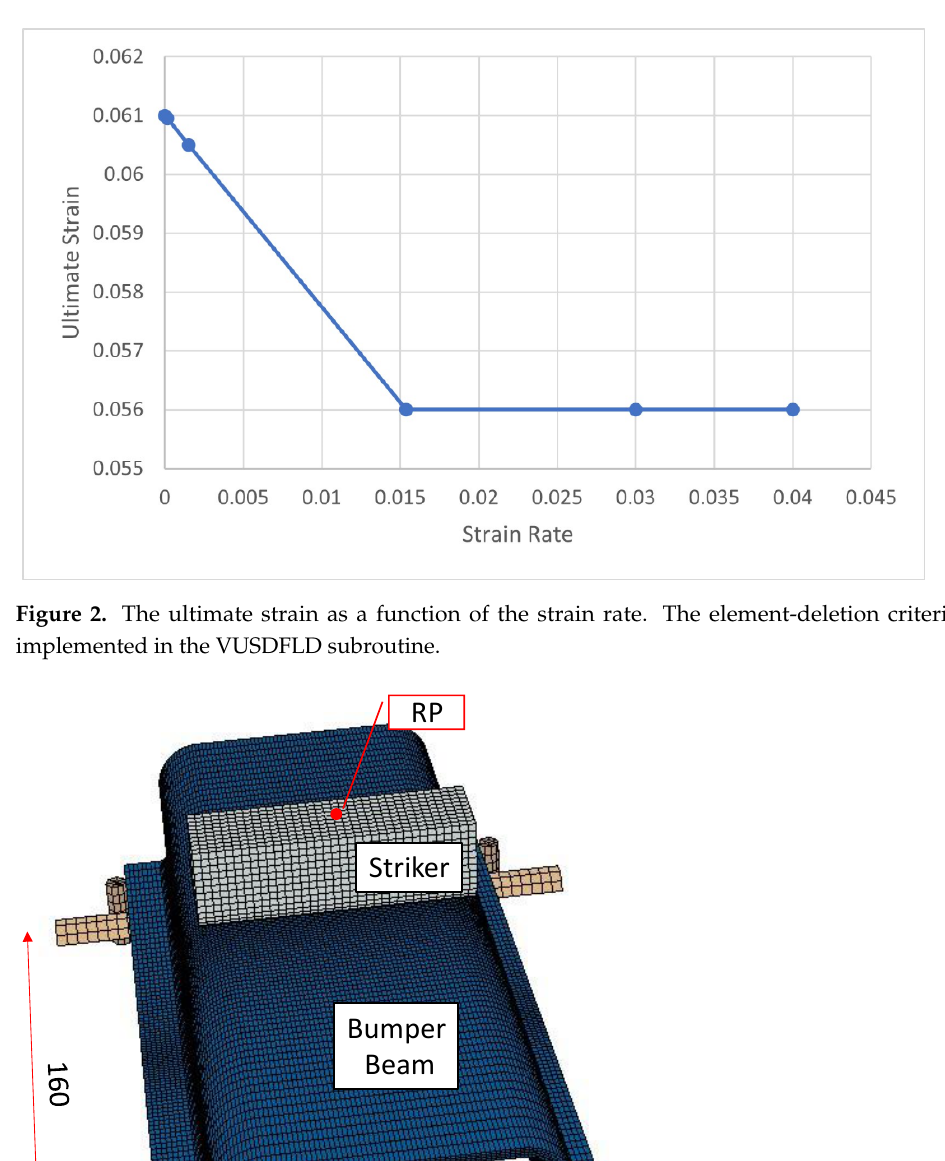
Figure 2. The ultimate strain as a function of the strain rate. The element-deletion criterion is imple- mented in the VUSDFLD subroutine.